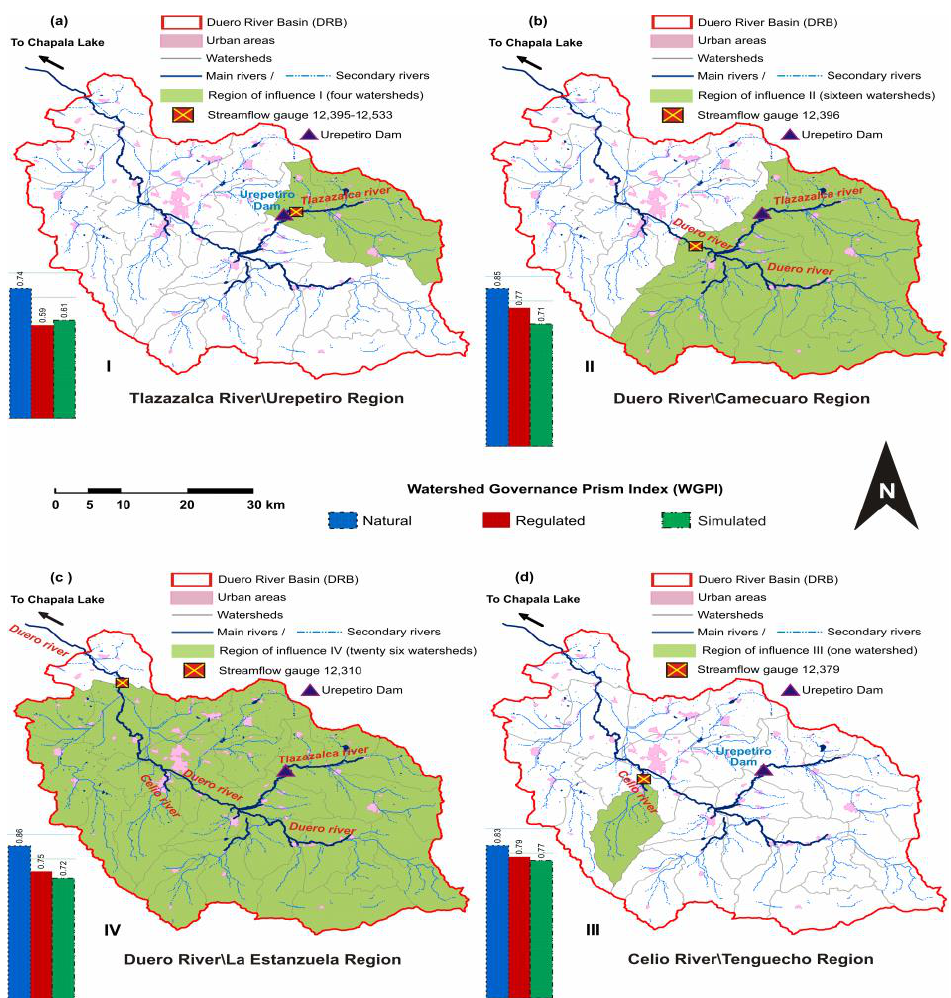
Figure 8. The four regions of influence: ( a ) Urepetiro — I, ( b ) Camecuaro — II, ( c ) Tenguecho — III, and ( d ) La Estanzuela — IV. These were proposed to evaluate the Watershed Governance Prism Index (WGPI) for evaluation in the natural (1936 – 1955), regulated (1956 – 1999), and simulated periods (2000 – 2070), (first bar, second, and third, respectively). Each region of influence is delimited at the outlet of the watershed by a gauging station. Source: own elaboration created with Qgis v2.18.21 and data from the Instituto Nacional de Estadística y Geografía (INEGI) and Fideicomiso de Riesgo Compartido (FIRCO).